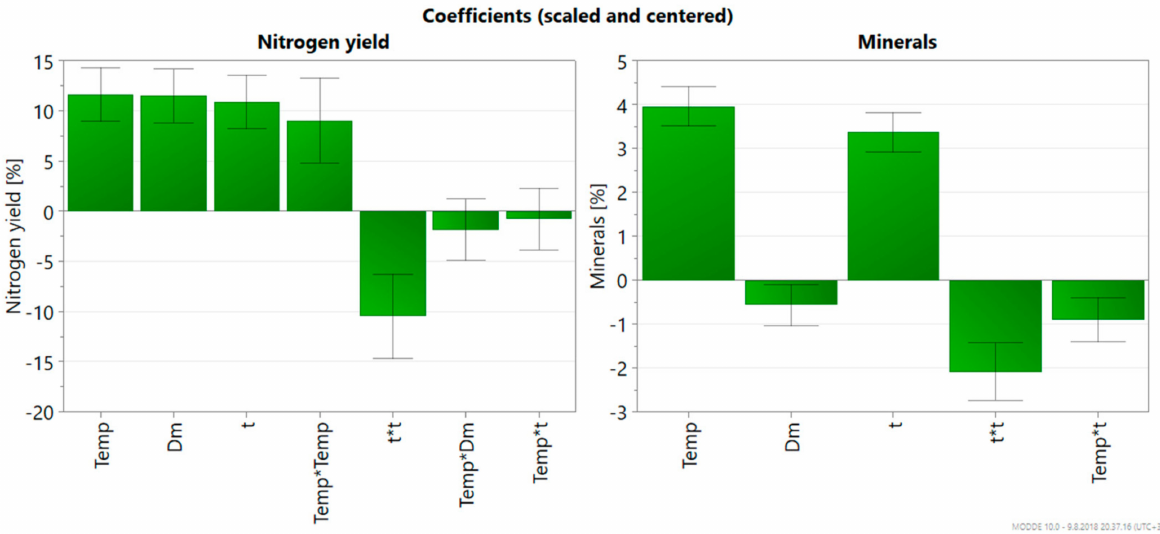
Figure 3. Factors affecting nitrogen and mineral yield in the processing of chicken MDCM clean